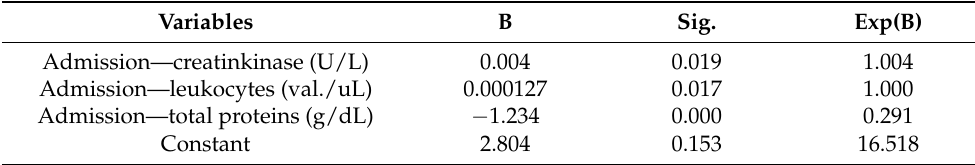
Table 4. The influence of bioumoral parameters on the relative instantaneous risks of mortality in our patients (variables included in the regression equation). Variables B Sig. Exp(B) Admission—creatinkinase (U/L) 0.004 0.019 1.004 Admission—leukocytes (val./uL)